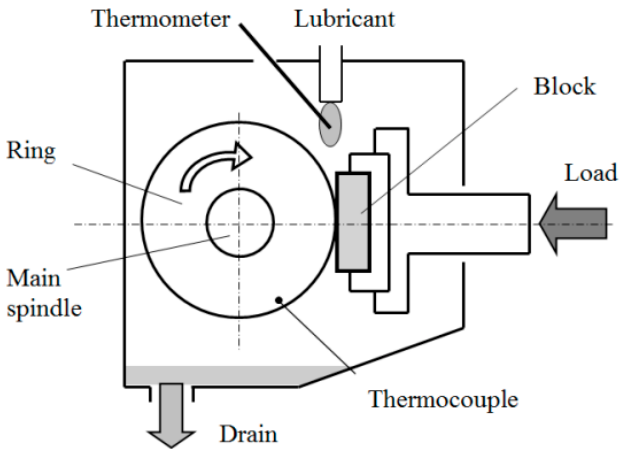
Figure 4. Schematic diagram of ring-block friction and wear tester. Reprinted with permission from Ref. [12]. 2017, The Japan Society of Mechanical Engineers.